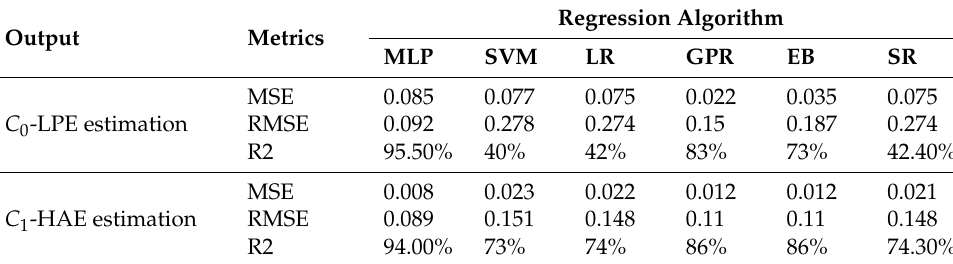
Table 5. Performance comparison between several regression algorithms.